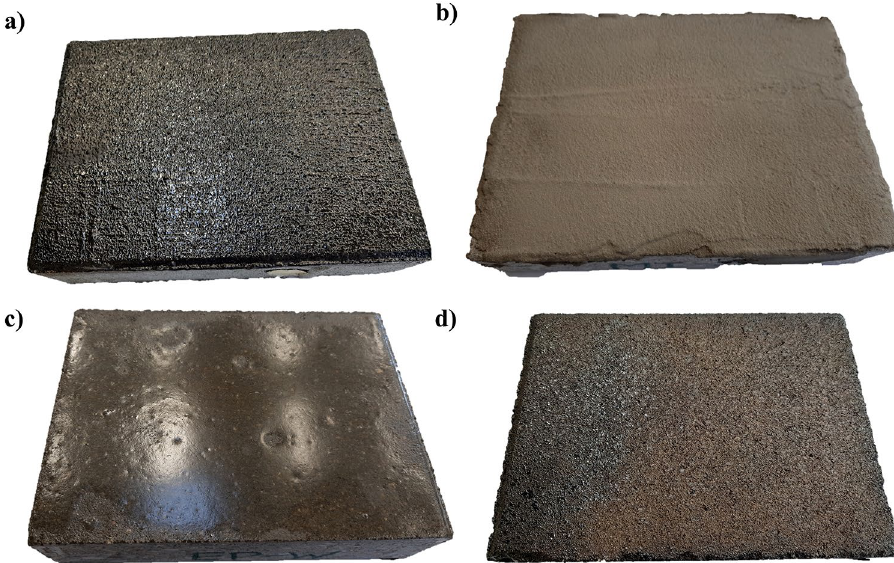
Figure 3. Coating materials applied in concrete slabs with wet substrate ( a ) BW ( b ) MI ( c ) EP ( d ) BR.